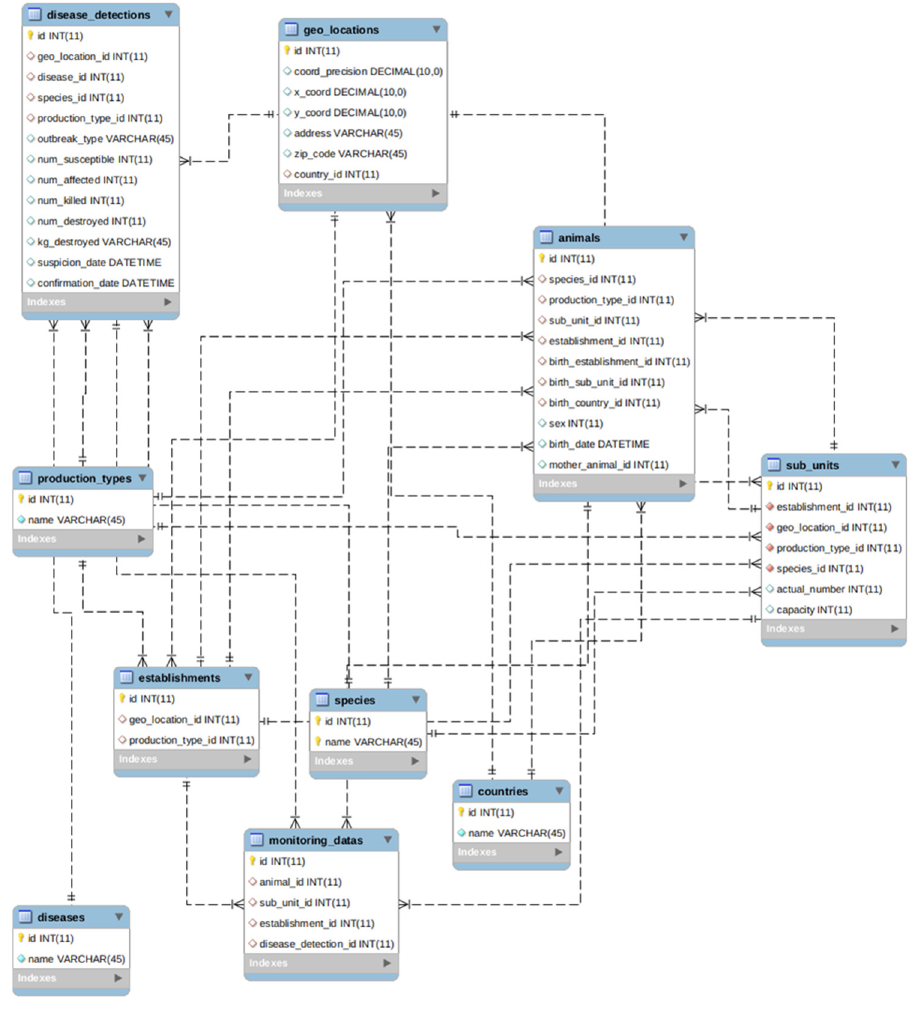
Figure 4. Entity Relation Diagram of our implementation of SIGMA animal disease data model.